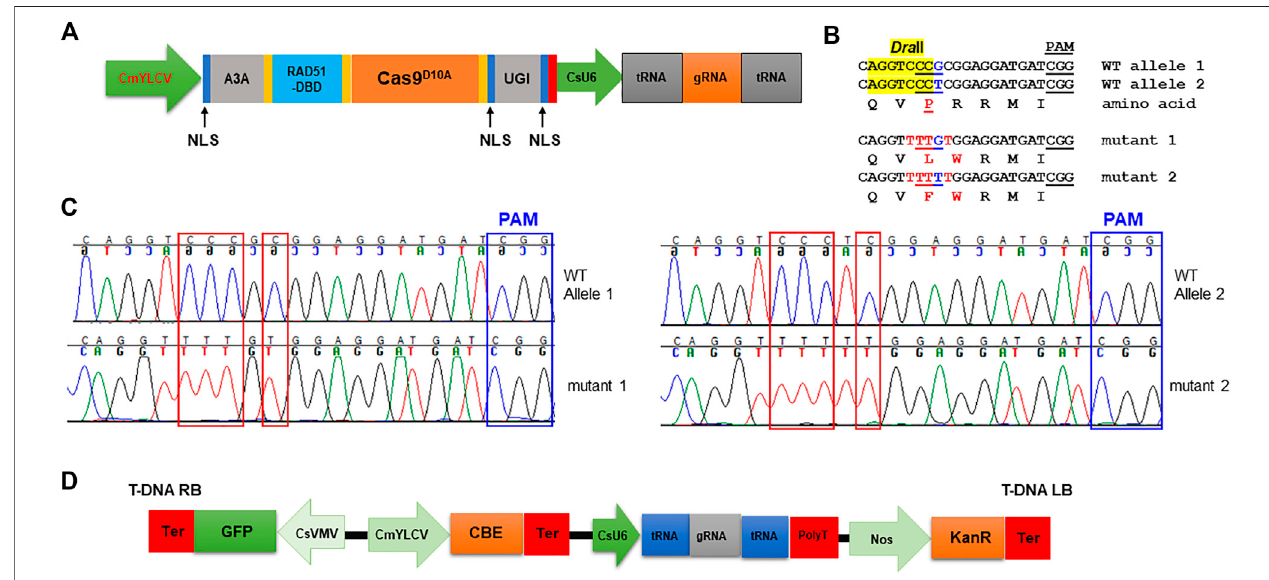
FIGURE3| PrecisegeneeditingincitruswithcytosinebaseeditorA3A-RAD51-DBD via transientexpression. (A) Illustrationofcytosinebaseeditingsystem(CBE). A3A, human APOBEC3A cytidine deaminase; RAD51-DBD, RAD51 DNA-binding domain; UGI, uracil glycosylase inhibitor; Cas9 D10A , Cas9 nickase; NLS, nuclear localization signal; CsU6, citrus U6 promoter. (B) CBE base editing of the ALS gene via transient expression assay. There are two ALS alleles in citrus. Two gRNAs (gRNA1: CAGGTCCCGCGGAGGATGATand gRNA2: CAGGTCCCTCGGAGGATGAT)weredesigned toeditboth ALS allelesusing themultiplex CBE construct. TheaminoacidsarealignedunderthecorrespondingDNAsequences.Therestrictionenzyme Dra II-resistantPCRampliconwassubjecttocloningandsequencing.The restriction enzyme Dra II recognition site, highlighted in yellow. Edited sites, in red font. (C) Chromatograms for (B). Mutation sites are indicated within red rectangles. (D) T-DNA part of the CBE